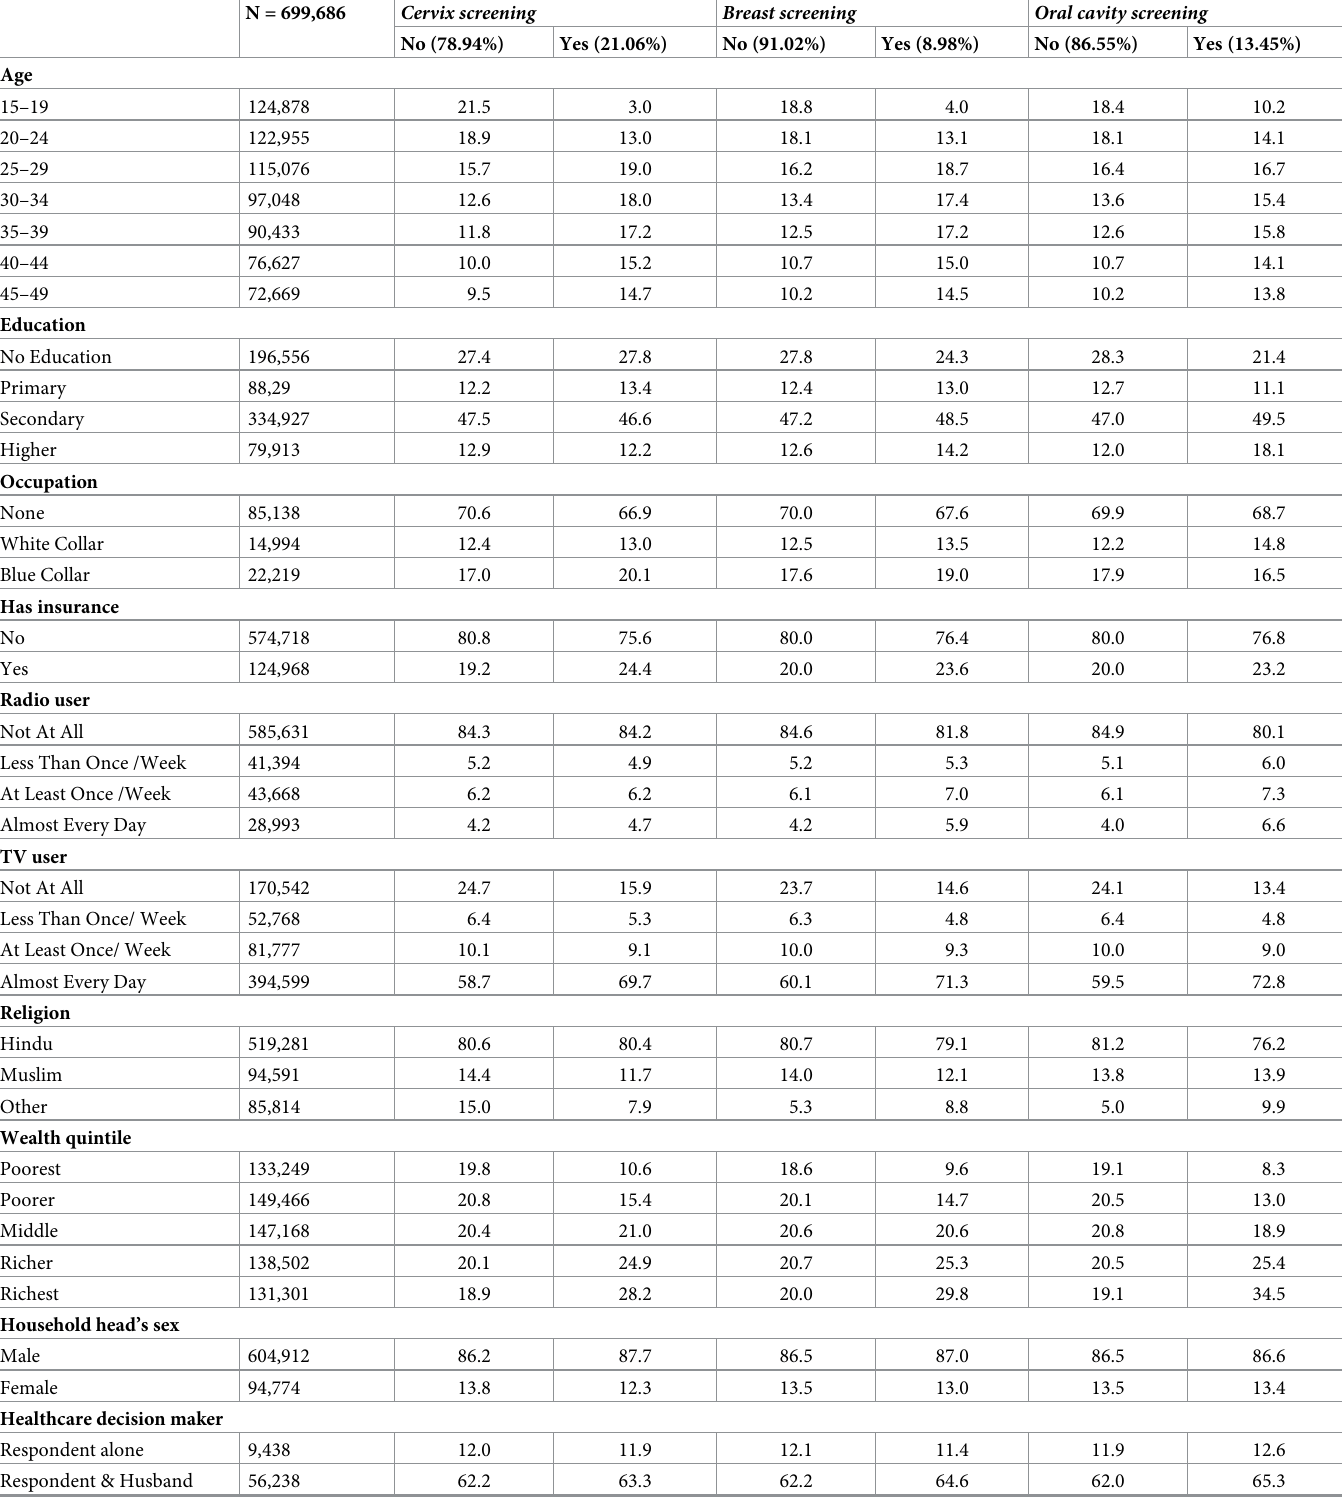
Table 2. Prevalence of breast cancer, cervix and oral cavity test. N = 699,686 Cervix screening Breast screening Oral cavity